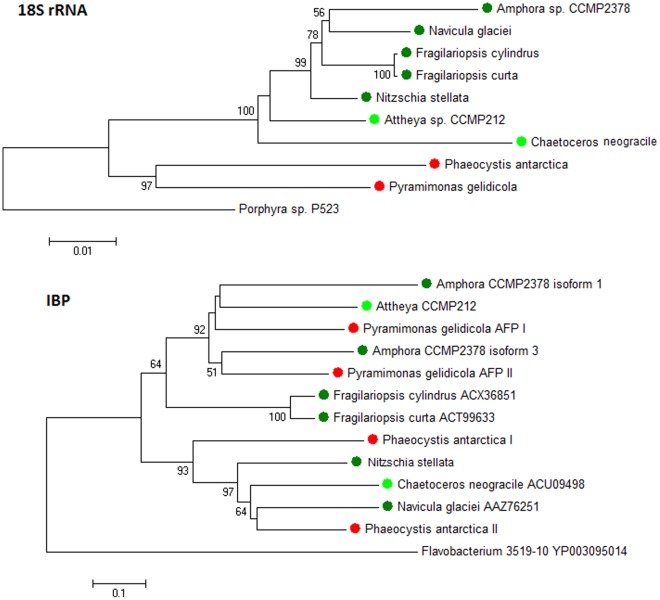
Incongruence between phylogenies of polar algae based on 18S rRNA and ice-binding protein sequences trees.Dark green symbols, Pennate diatoms; light green symbols, centric and quasi-centric diatoms; red symbols, prymnesiophyte and prasinophyte algae. IBP tree rooted with a bacterial IBP. Bootstrap values <50 are not shown. Accession numbers for the 18S sequences are Amphora sp., JQ240485; Navicula glaciei, EF106788; Fragilariopsis cylindrus, AY485467; Fragilariopsis curta, EF140623; Nitzschia stellata, JQ240484; Attheya sp., JQ240486; Chaetoceros neogracile, EU090012; Phaeocystis antarctica, X77477; Pyramimonas gelidicola, EU141942, Porphyra sp. P523, GU319853. Accession numbers of IBPs not given in the figure are given in Table S2.